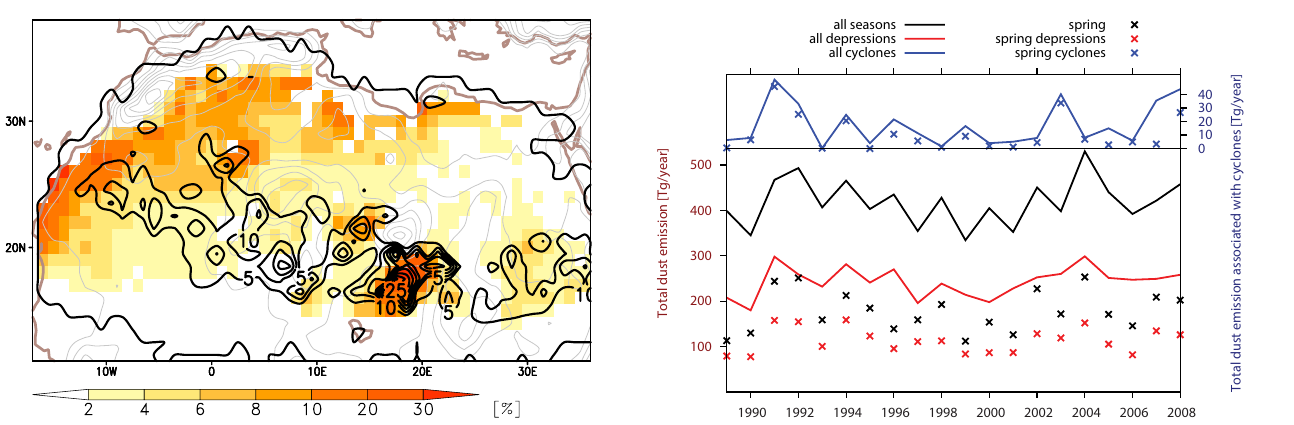
with few depressions, suggesting that these events are partic- ularly intense.